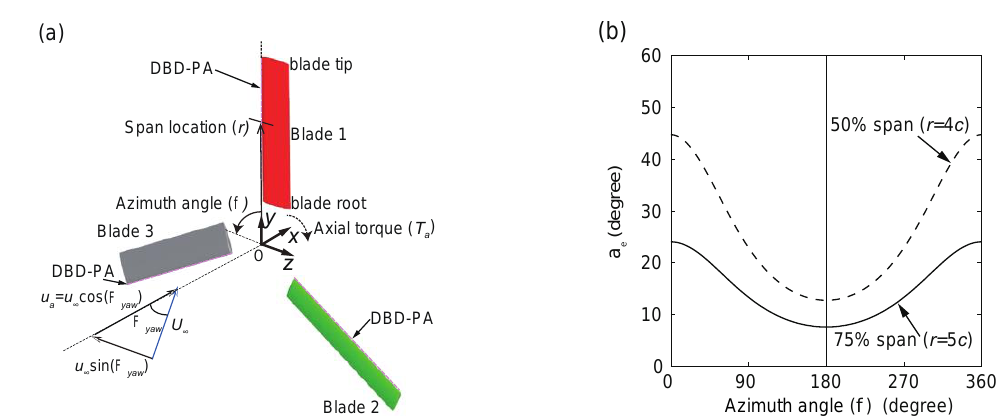
Figure 2. Configuration of the HAWT blade model ( a ) and time histories of α e at the selected span sections ( b ).